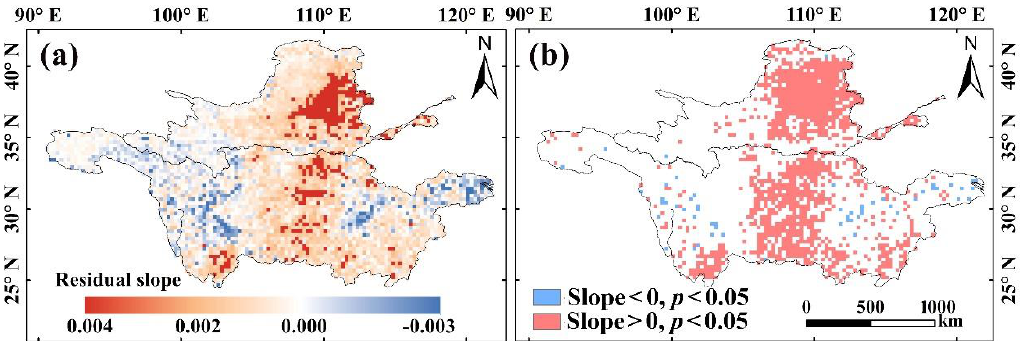
Figure 8. Spatial distribution of the NDVI residual variation trend ( a ) and significance ( b ).